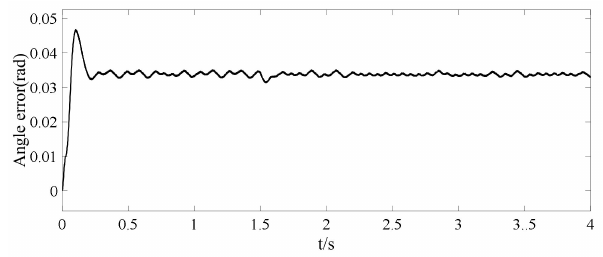
Figure 16. Rotation position error waveform during acceleration